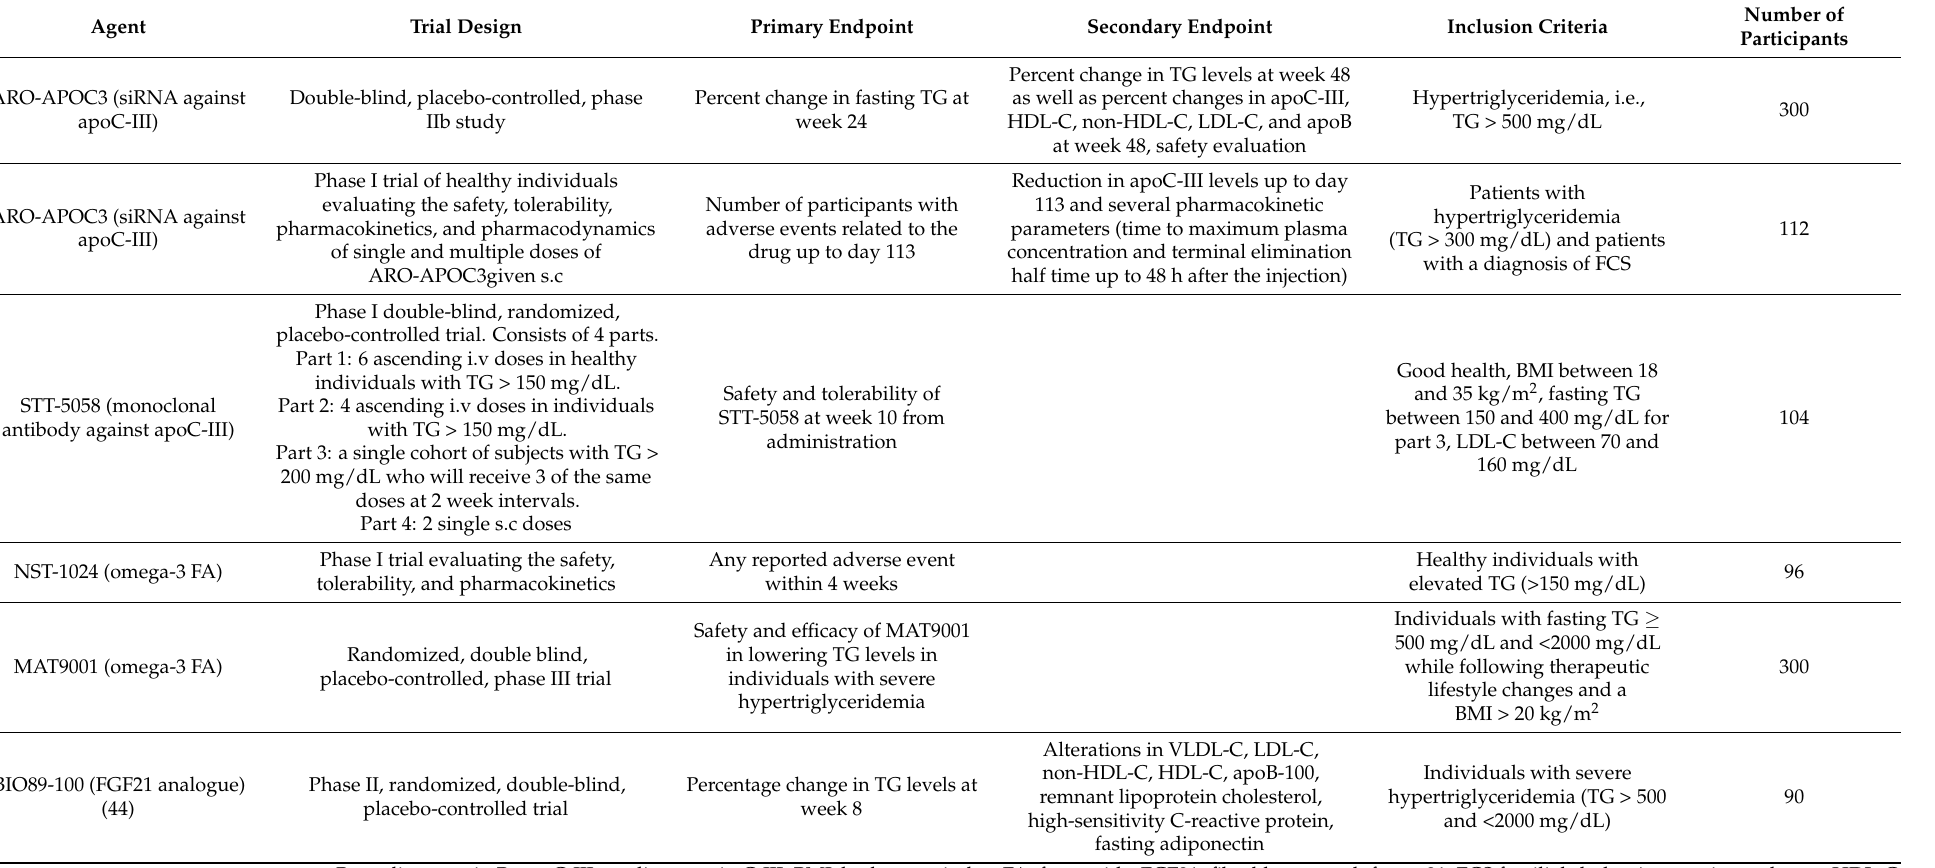
Table 1. Summary of the ongoing early-phase clinical triglyceride-lowering